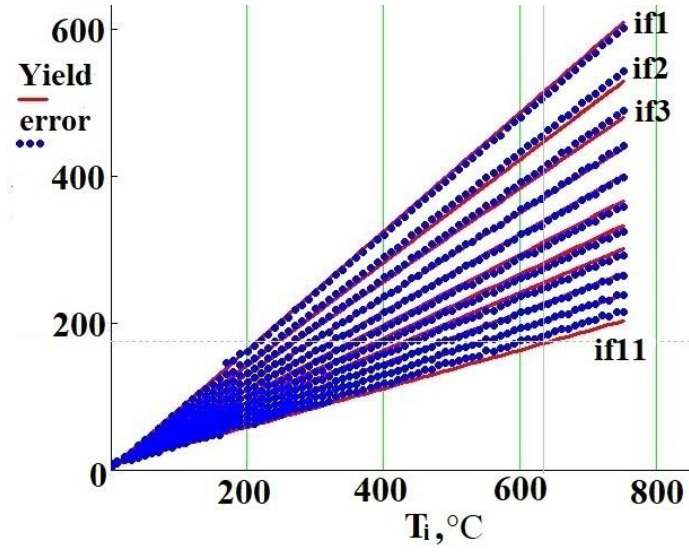
Figure 10. Estimated regression equation and observed values of “ error ” .